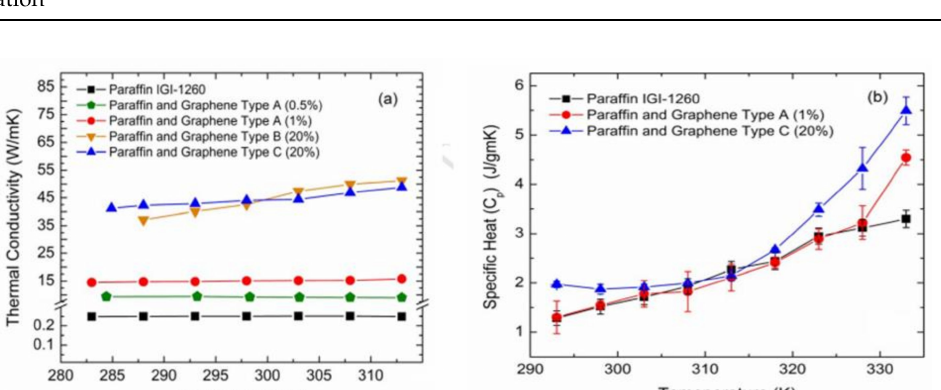
Figure 12. Hybrid graphene–PCM thermal characteristics: ( a ) temperature-dependent enhancement factor of the thermal conductivity of graphene—paraffin composites with various graphene loadings. For comparison, the outcomes for pristine paraffin are also shown: ( b ) temperature-dependent specific heat of the composites and the reference pure paraffin. (Reproduced from [262] with